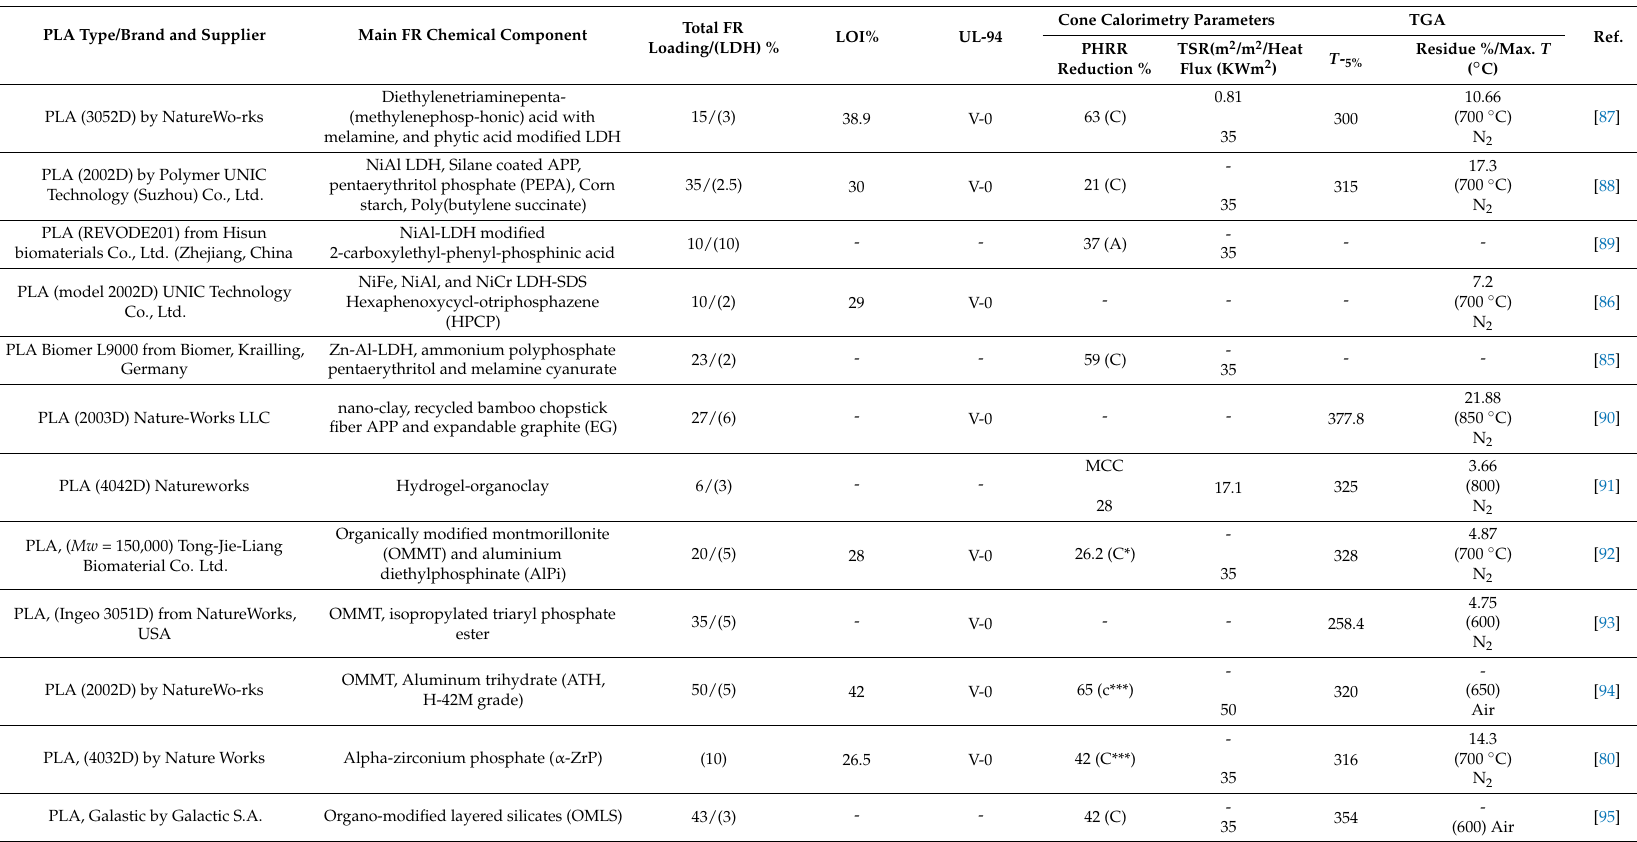
Table 2. Typical 2D nanomaterials for flame-retardant